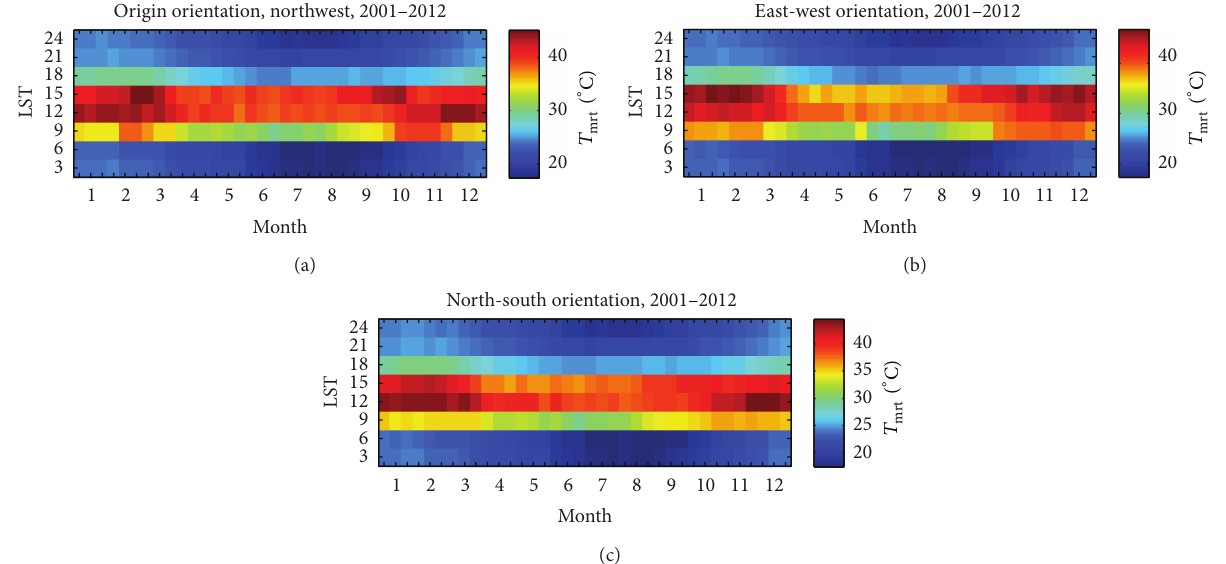
Figure 4: The temporal distribution of 𝑇 at the urban street in its origin orientation of a northwest-southeast direction (a), east-west mrt orientation (225 ∘ ) (b) and north-south orientation (315 ∘ ) (c).